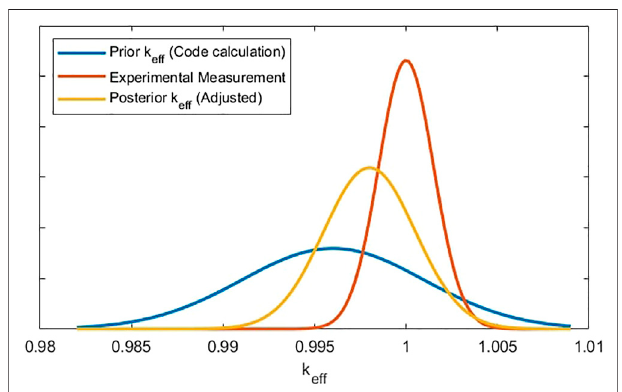
FIGURE 1 | k eff consolidated con fi dence from experiment and prior